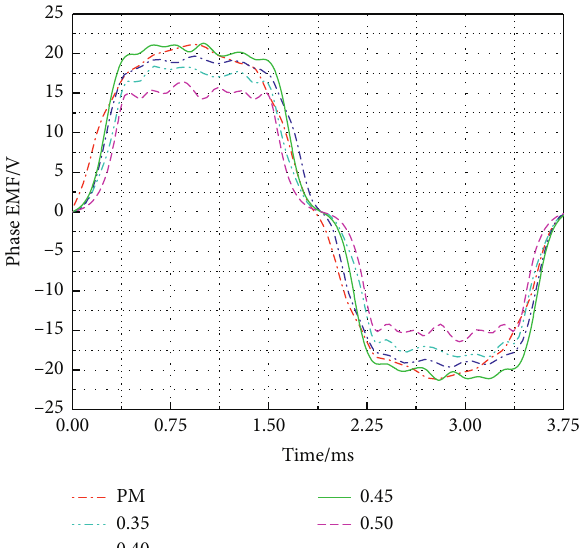
Figure 9: The waveform of induced EMF with the different claw tip pole arcs.